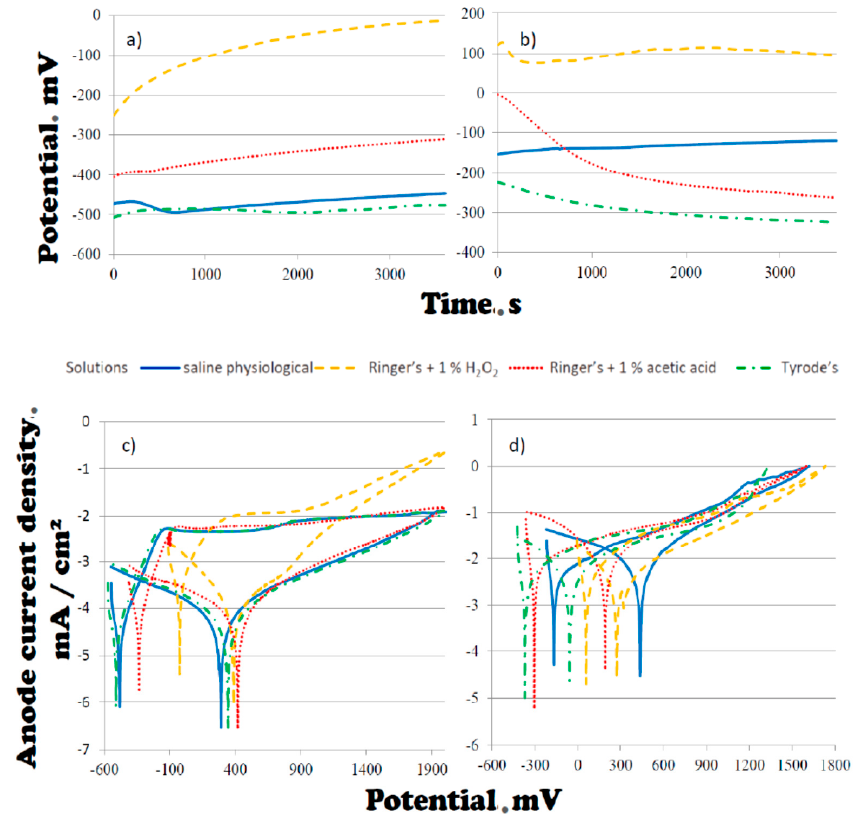
Figure 27. Curves registered in the corrosion resistance test of the Ti6Al4V alloy manufactured by the SLS method in variants Ti solid 4 ( a , c ) and Ti solid 8 ( b , d ). ( a , b ) Open circuit potential and ( c , d ) anode curves of the potentiodynamic method.